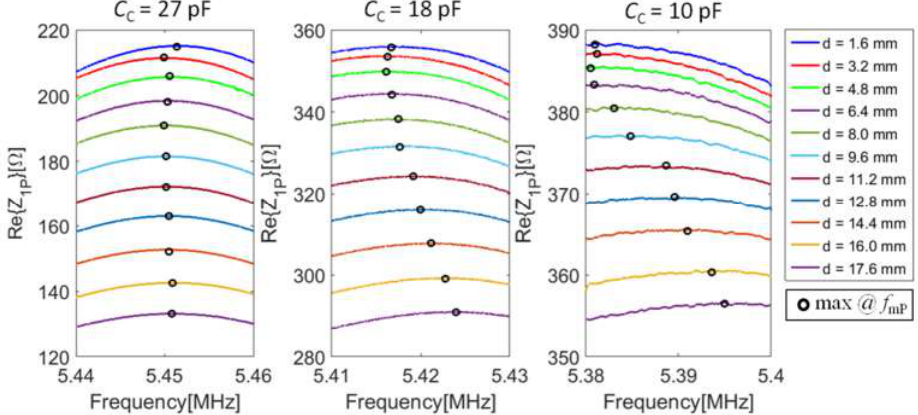
Figure 18. Measured maxima in Re{ Z 1P } around f S for different values of the compensation C C , varying the distance d between CL 1 and the RSU. The frequency of the maxima at f mP is highlighted with a black circle.